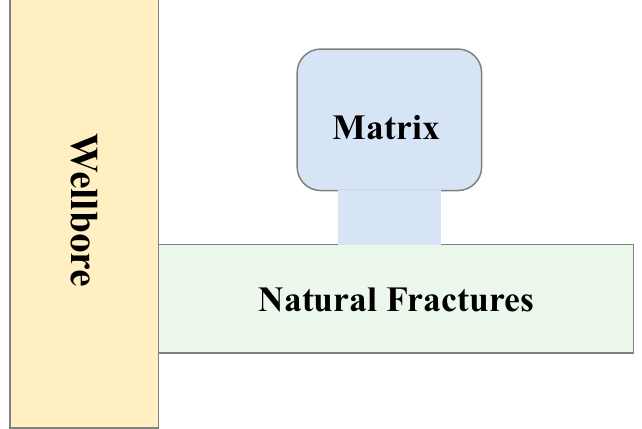
Figure 1. Schematic diagram of the well model in a fractured carbonate gas reservoir.